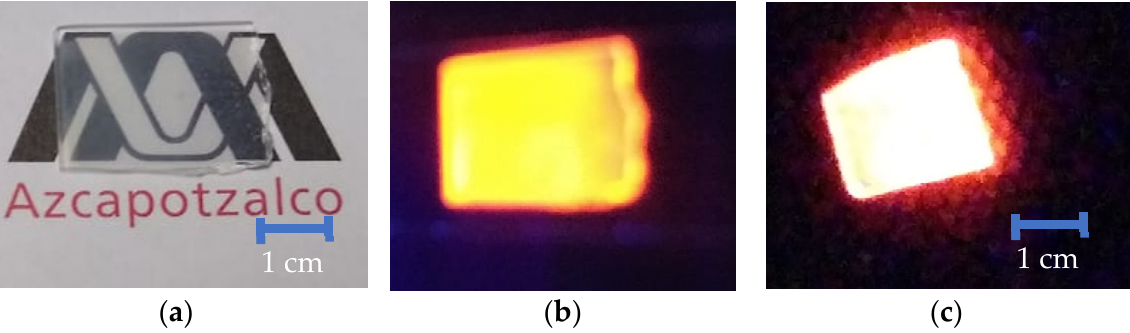
Figure 4. Photography of LuVO 4 : 2.5% at. Eu 3+ , 1.5% at. Bi 3+ films ( a ) without, ( b ) with UV-Vis short excitation (254 nm), and ( c ) with long UV-Vis on excitation (380 nm). The scanning micrographs of the films, shown in Figure 5, correspond to LuVO 4 : 2.5 at. % Eu 3+ , 1.5 at. % Bi 3+ film, deposited and annealed at 700 ◦ C (Figure 5a) and 1000 ◦ C (Figure 5b) at 10,000 ×